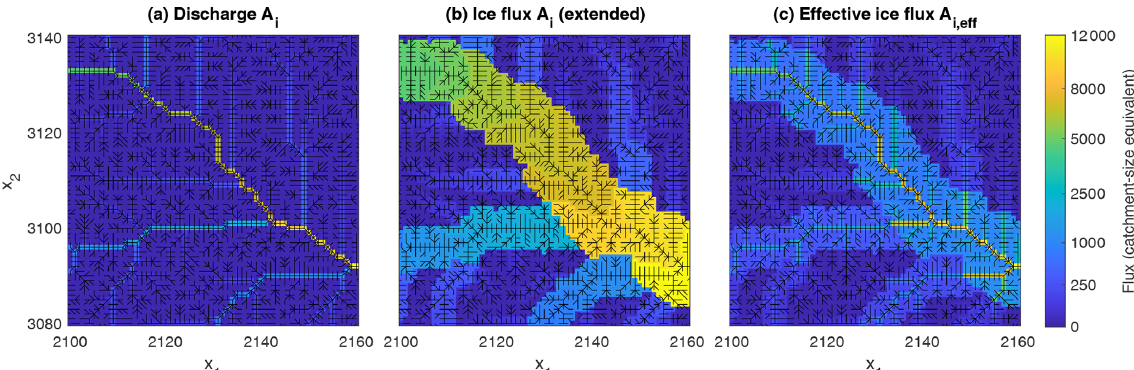
Figure 2. Illustration of the fluxes in the swath around the cardinal flow path. The domain corresponds to the small, white square in Fig. 3.